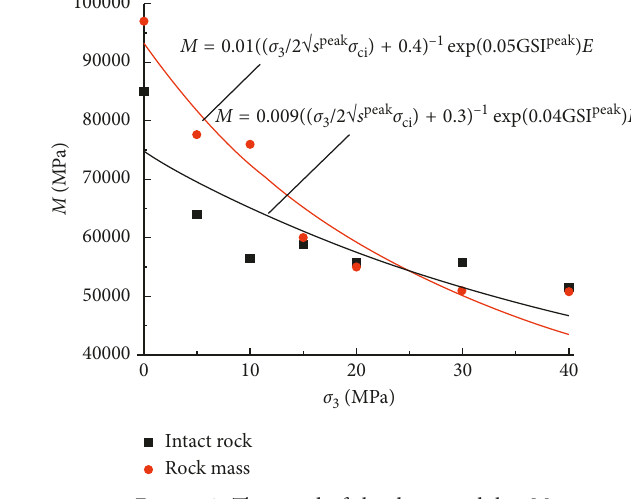
Figure 9: The trend of the drop modulus M .